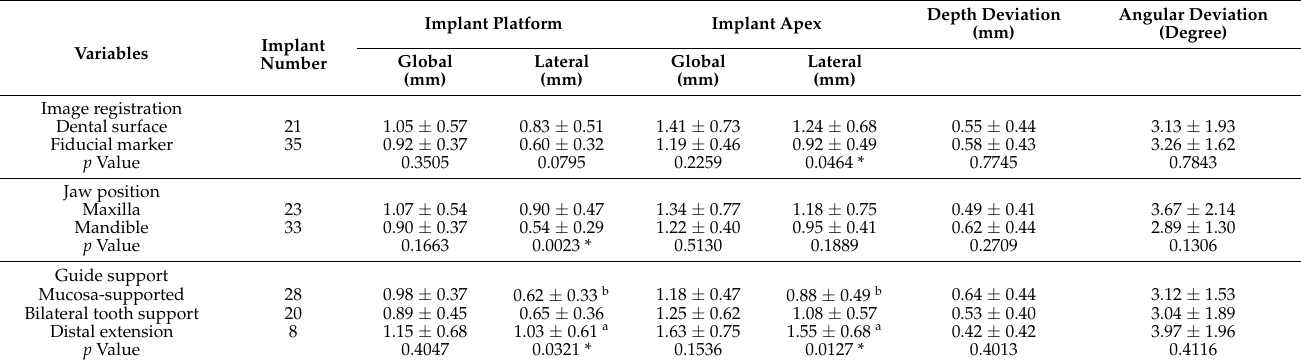
Table 3. Deviations of variables that significantly influence fully guided implants.